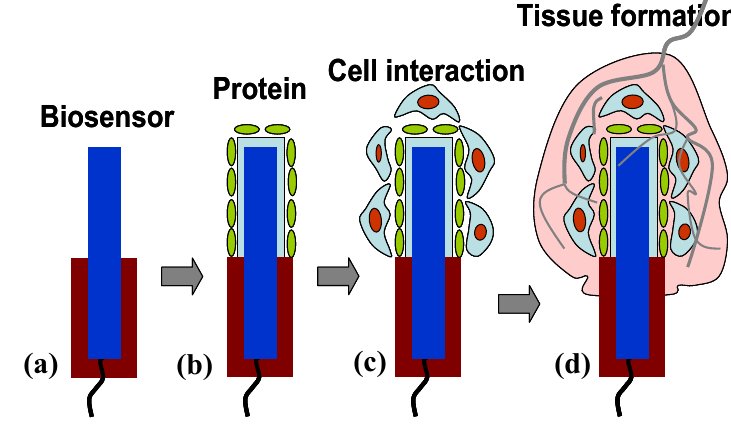
Figure 10. Bio-fouling progresses on the sensor’s surface after implantation into the body; (a) biosensor, (b) protein absorption, (c) cell deposition, and (d) fibrosis and angiogenesis. interactionTissue formation interactionTissue formation Cell Cell Protein Protein Biosensor